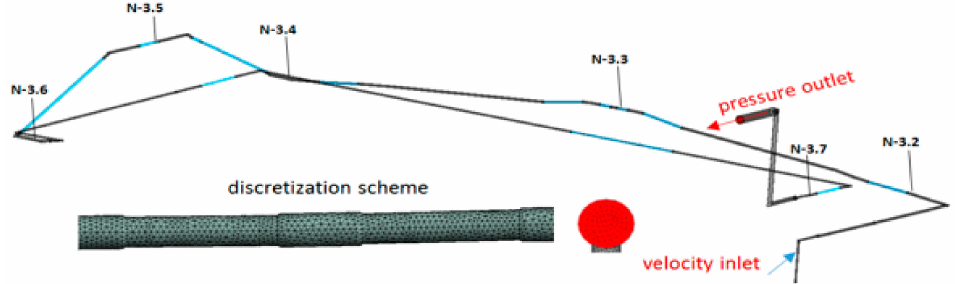
Figure 3. Geometry and method of discretization of the 3D model of the entire 100 m long laboratory